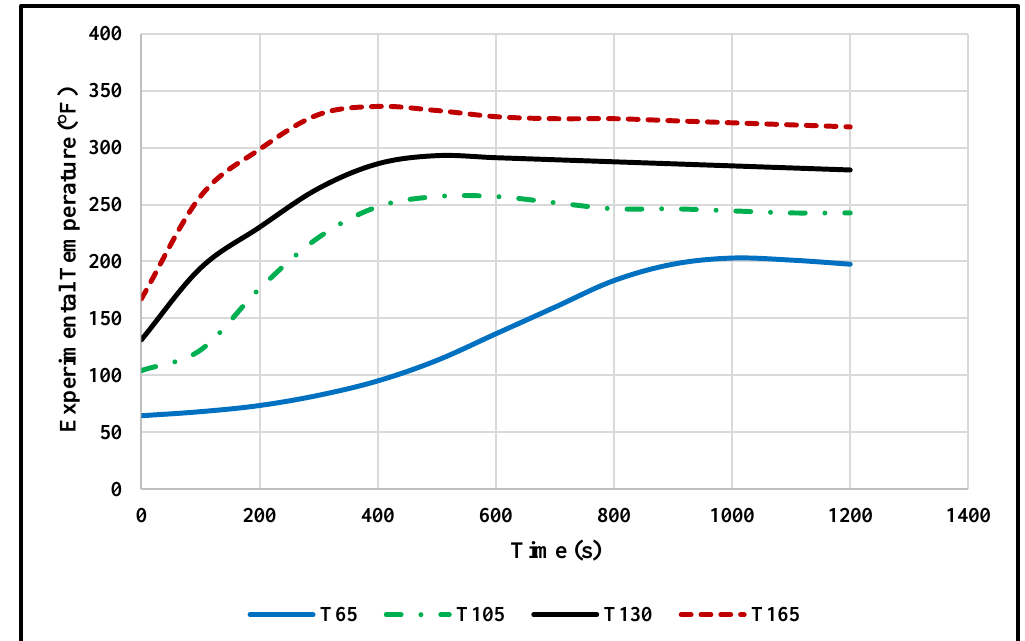
Figure 3. Temperature profiles for different initial vessel temperatures.